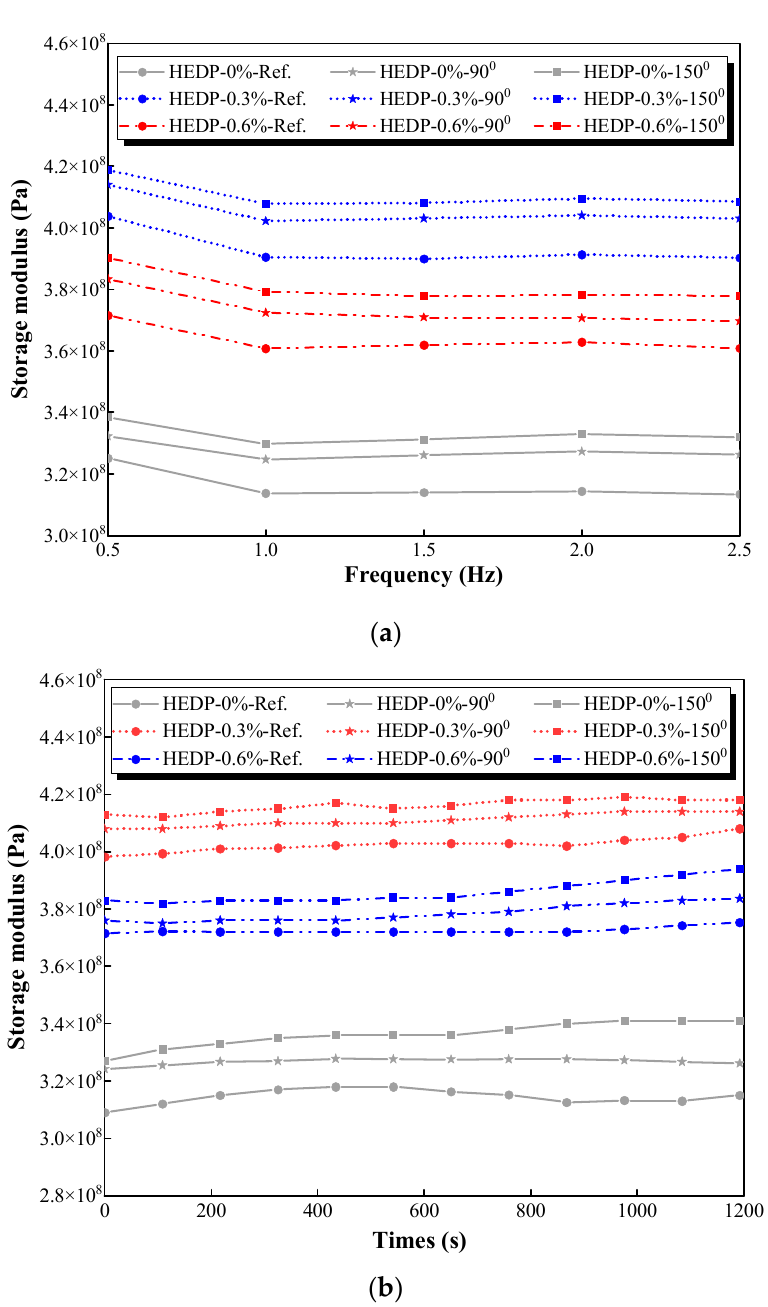
Figure 6. Storage modulus of 28d FR-AASC. ( a ) Frequency (0.5–2.5Hz), ( b ) Time (0–200s).